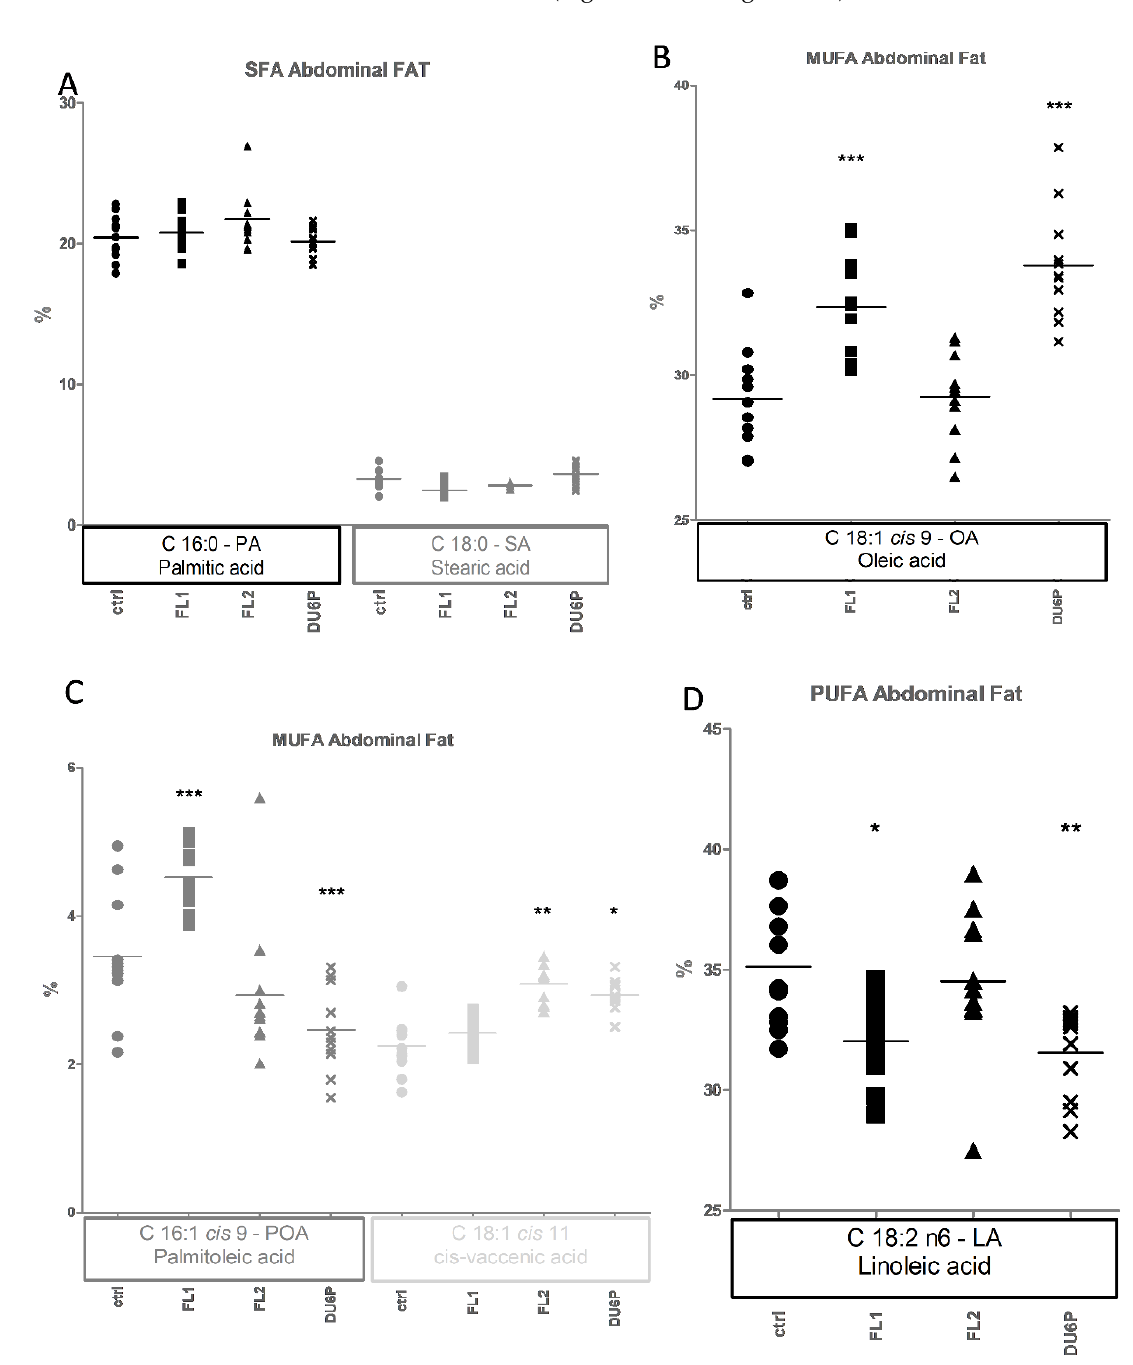
Figure 9. Abdominal fat composition of the most abundant SFAs (small symbols, A ), MUFAs (medium symbols, B , C ), and PUFAs (large symbols, D ) in control (circles), FL1 (squares), FL2 (triangles) and DU6P (crosses). Different FAs are represented using different tonalities. Data are illustrated as the mean ± SEM (standard error of the mean) and designated significant if p < 0.05 (Bonferroni posttest: * p < 0.05; ** p < 0.01; *** p < 0.005, in comparison with control of the same